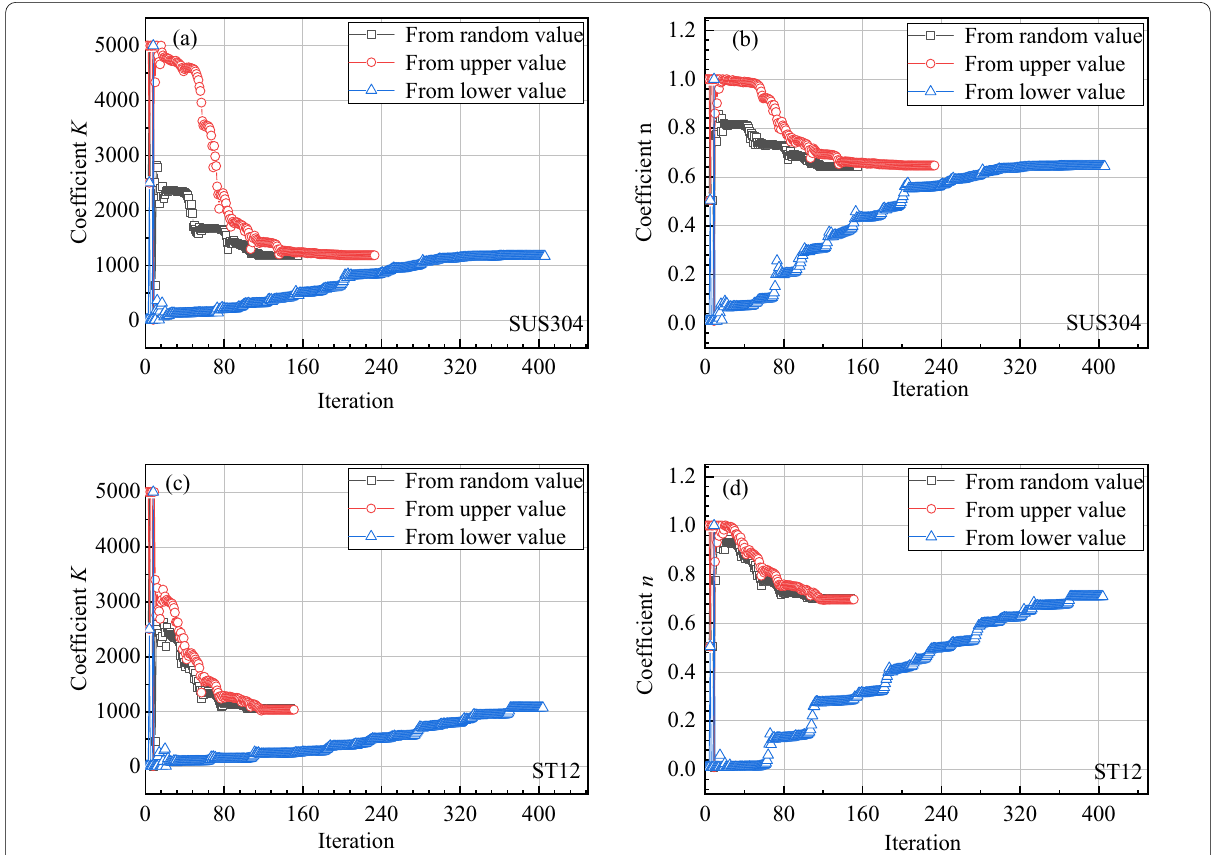
Figure 18 Learning process of Ludwik hardening parameters: a Parameter K of SUS304, b Parameter n of SUS304, c Parameter K of ST12, d Parameter n of